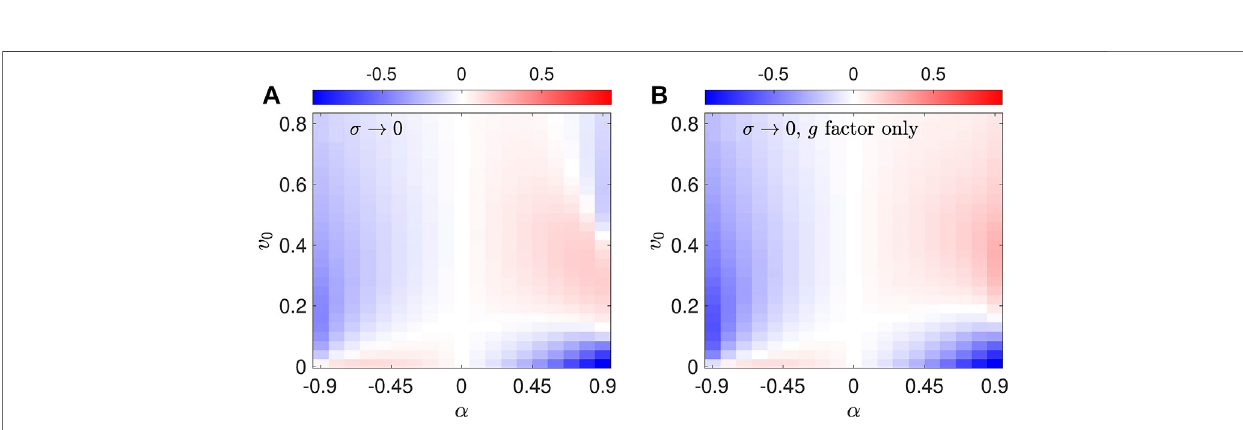
Frontiers in Physics |